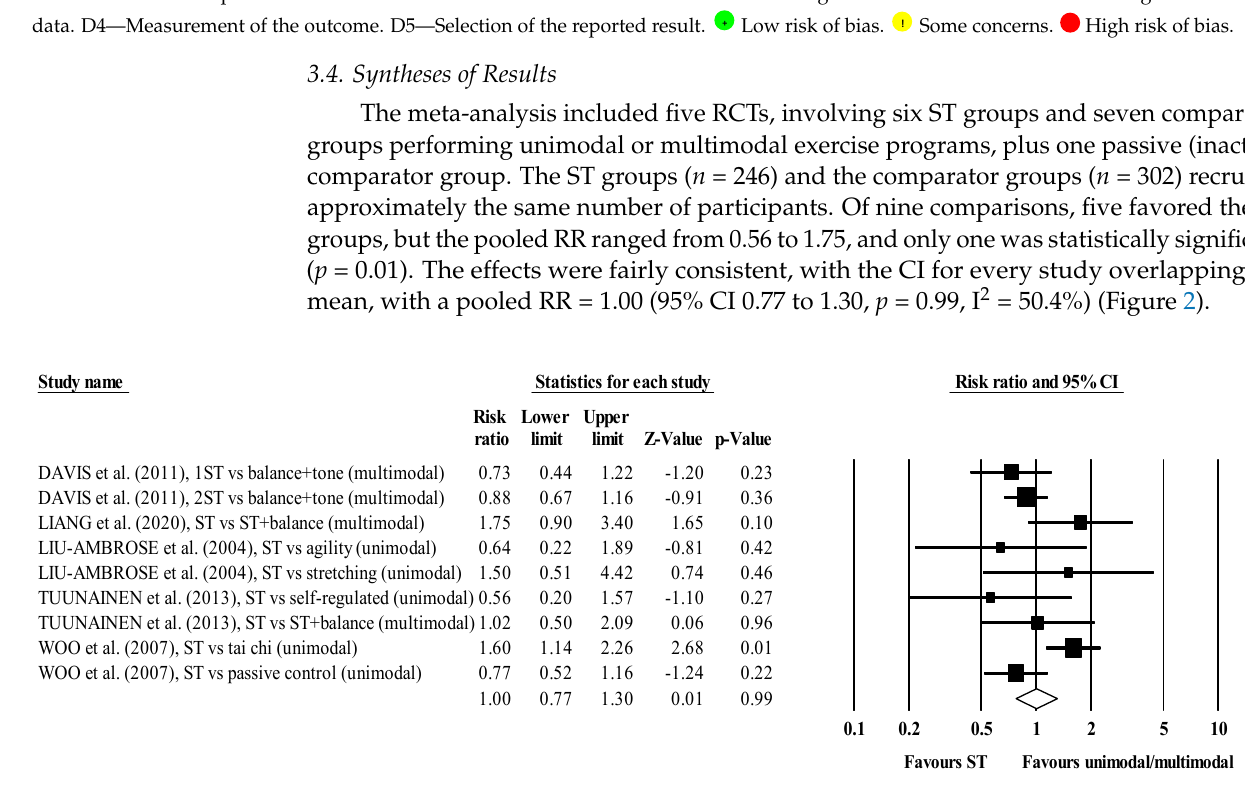
Figure 2. Forest plot for risk of falling after participating in ST programs compared to unimodal/multimodal active/passive control conditions.